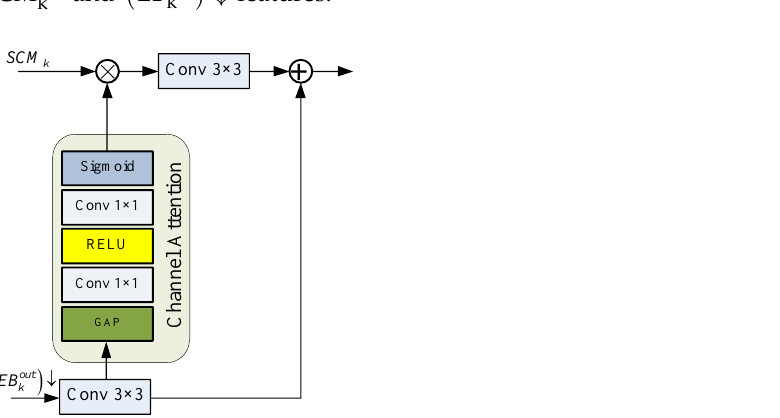
Figure 5. The structure of Channel Attention Fusion